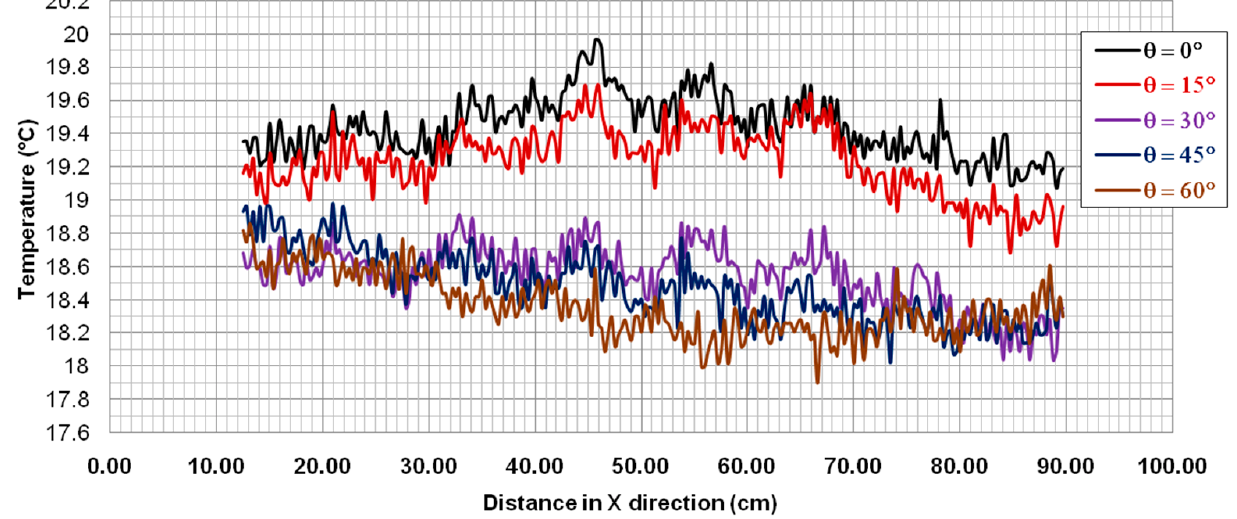
Figure 7. Temperature profiles for different angles of incident waves ( θ = θ i ).